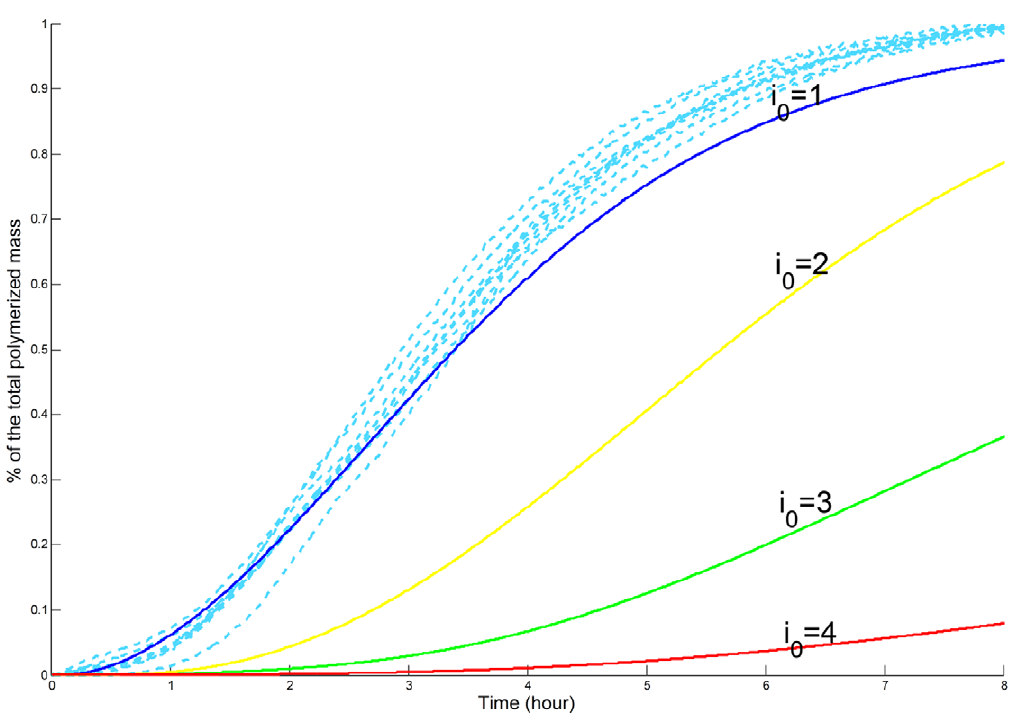
Figure 2. Simulation vs Experiments for Experimental Set 1, for an initial PolyQGST concentration of 100 m M : The parameters were first estimated for an experimental set of initial concentration 285 m M , then we compared the experimental measures (dotted lines) for an initial concentration 100 m M with the simulations (in solid lines) for i 0 ~ 1,2,3,4 : We see that the smaller i 0 is, the closer the simulation to experimental